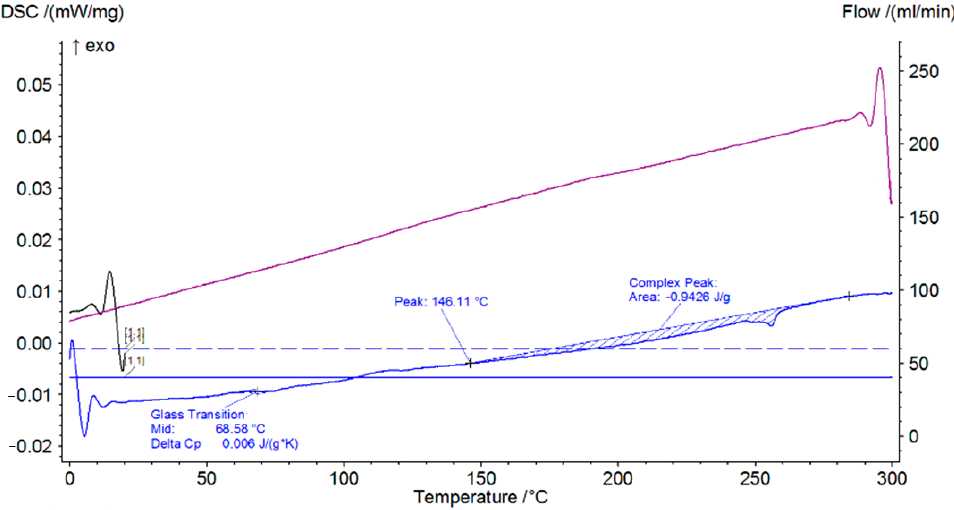
Figure 2. Glass transition temperature of the specimen.